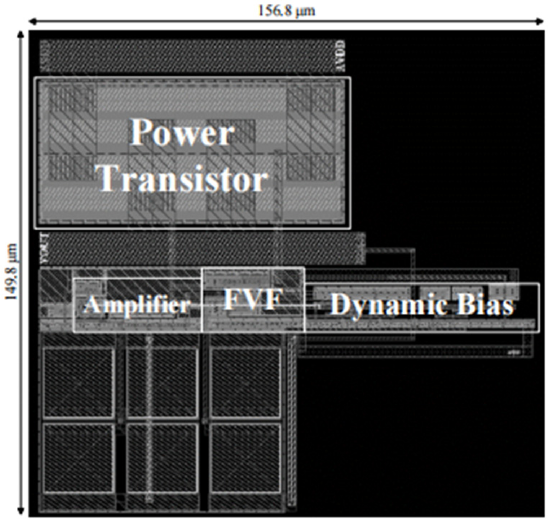
Figure 15. Layout of the proposed LDO.